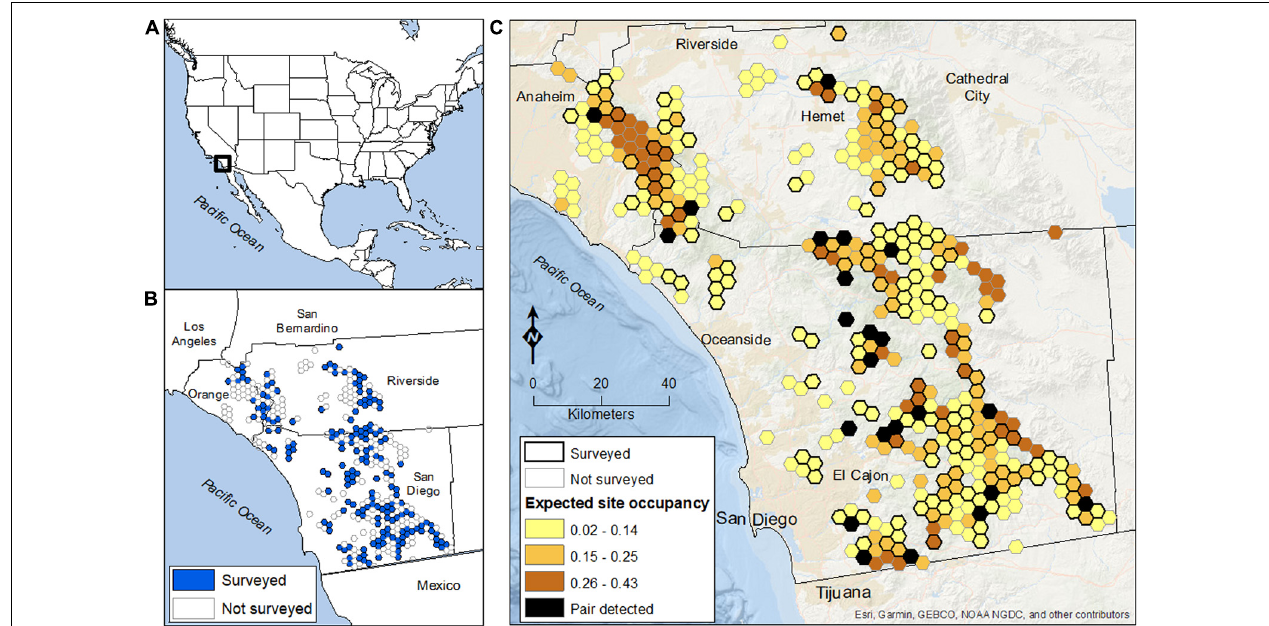
FIGURE 1 | The golden eagle study area, sampling grid, and expected estimates of site occupancy in coastal southern California, United States. (A) Location of the study region in the western U.S. (B) Extent of the sampling grid of 13.9 km 2 hexagon sites ( n = 384), including 175 randomly selected sites (blue hexagons) that were repeatedly surveyed for eagles in 2016 and 2017. (C) Spatial distribution of model-averaged values of expected site occupancy for territorial pairs of golden eagles. Black hexagons indicate sites where a pair of eagles was detected at least once (i.e., ψ conditional = 1.0). Mean expected occupancy across the 5,338-km 2 sampling frame was 0.156 (SE = 0.081), indicating that approximately 833 km 2 of the 5,338-km 2 study area was used by resident pairs of eagles (equivalent to about 60 occupied sites).